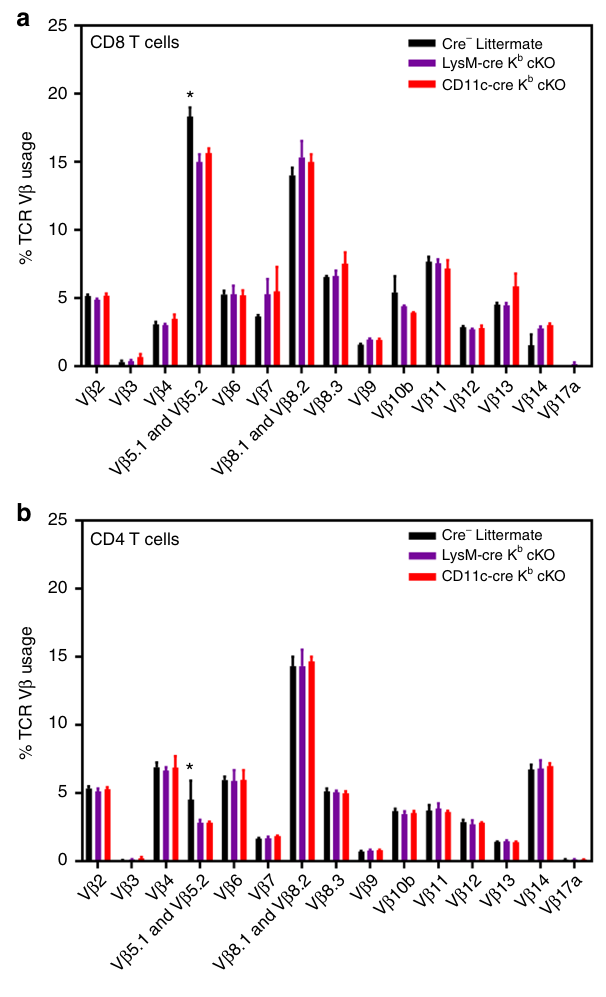
Fig. 3 Splenic TCR repertoire is not markedly affected by cell-speci fi c H-2K b deletion. Splenocytes were isolated from naïve 6 – 8-week-old animals ( N = 3 per group) and stained with anti-CD45, anti-CD4, and anti-CD8 antibodies, as well as antibodies speci fi c to each of the T-cell receptor V β regions listed. CD8 + T cells ( a ) and CD4 + T cells ( b ) isolated from the spleen show highly similar T-cell repertoires, with TCR V β 5 only impacted peripherally. Data presented as mean with error bars representing standard error of the mean (SEM). * denotes p < 0.05 as measured by